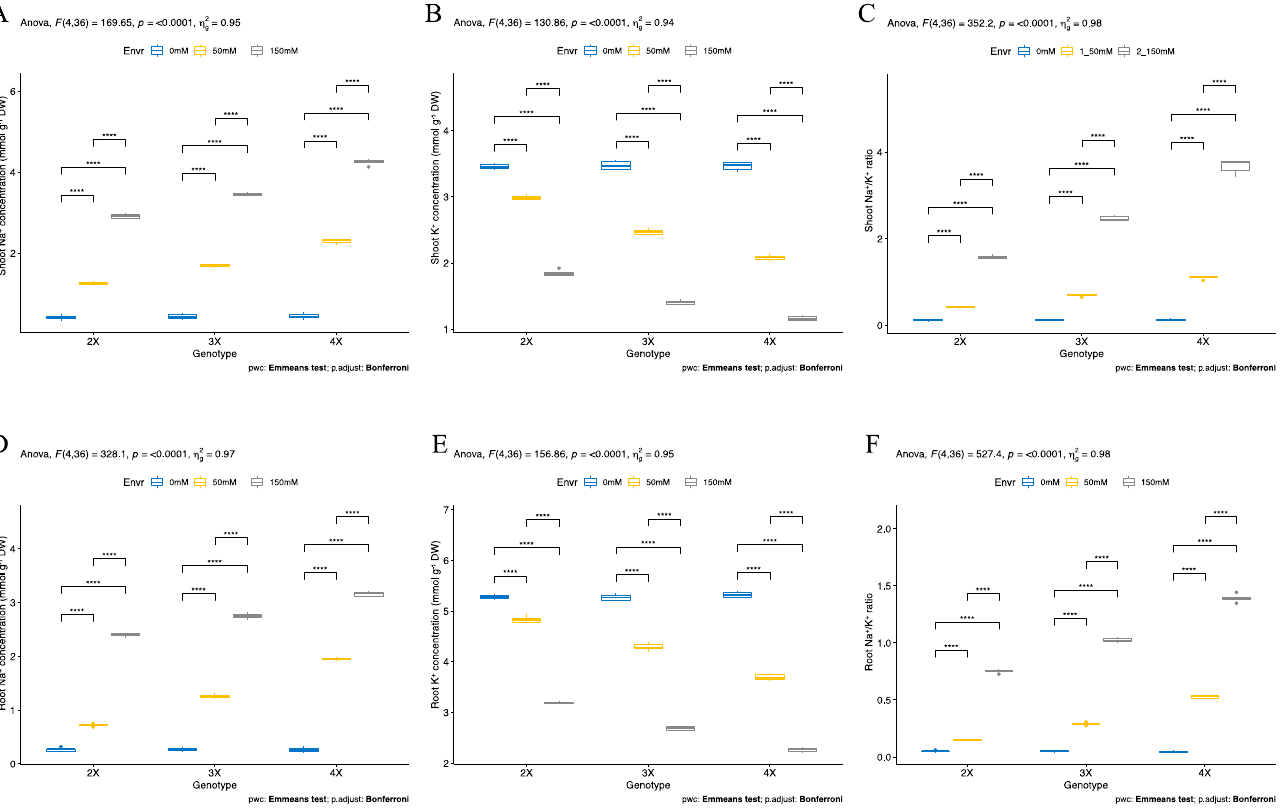
Figure 3. Ion content of different ploidy level sugar beet plants ( Beta vulgaris L.) at vegetative stage. ( A ) Shoot Na + concentration, ( B ) shoot K + concentration, ( C ) shoot Na + /K + ratio, ( D ) root Na + concentration, ( E ) root K + concentration, and ( F ) root Na + /K + ratio were measured in 42-day-old plants that were exposed to 0 mM, 50 mM, and 150 mM salt (NaCl) stress from germination. Means (± standard deviation) within the same graph followed by the Emmeans test and p -value adjusted by the Bonferroni method from five independent biological replicates ( n = 5). Asterisk indicates that ns—non-significant; **** significant at p < 0.0001.